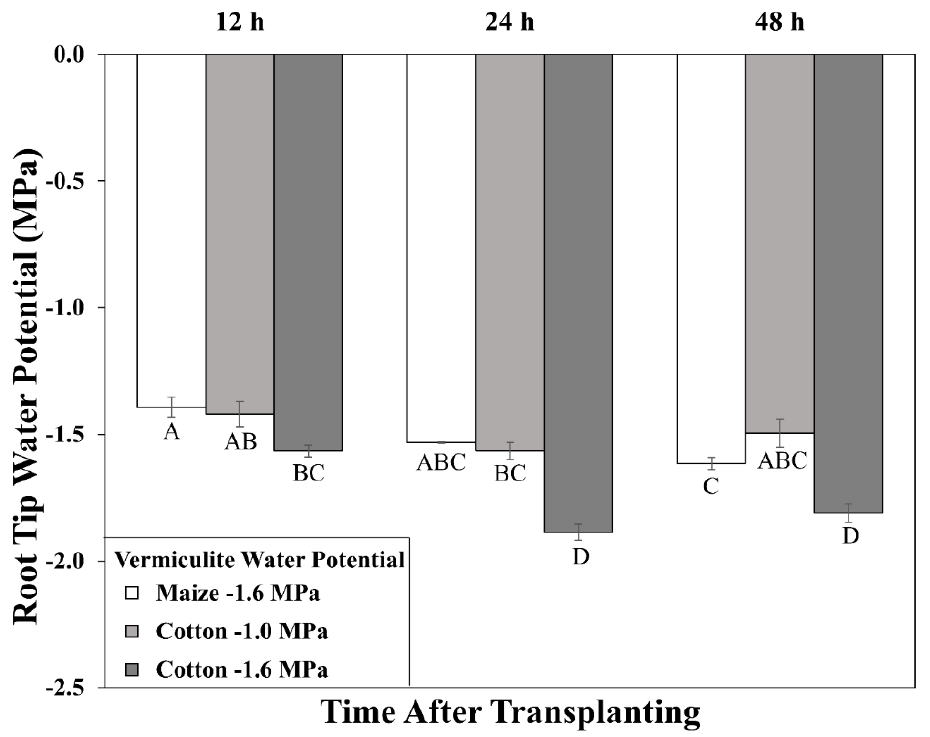
Figure 2. Time course of primary root tip (encompassing the elongation zone) water potential for cotton and maize seedlings after transplanting to water-stressed conditions. Vermiculite water po- tentials were − 1.0 MPa (co tt on) and − 1.6 MPa (co tt on and maize). Data are the means ± SE ( n = 3–4). ANOVA analysis compares the data across treatments, time points, and species; different letters indicate significant differences ( p < 0.01).